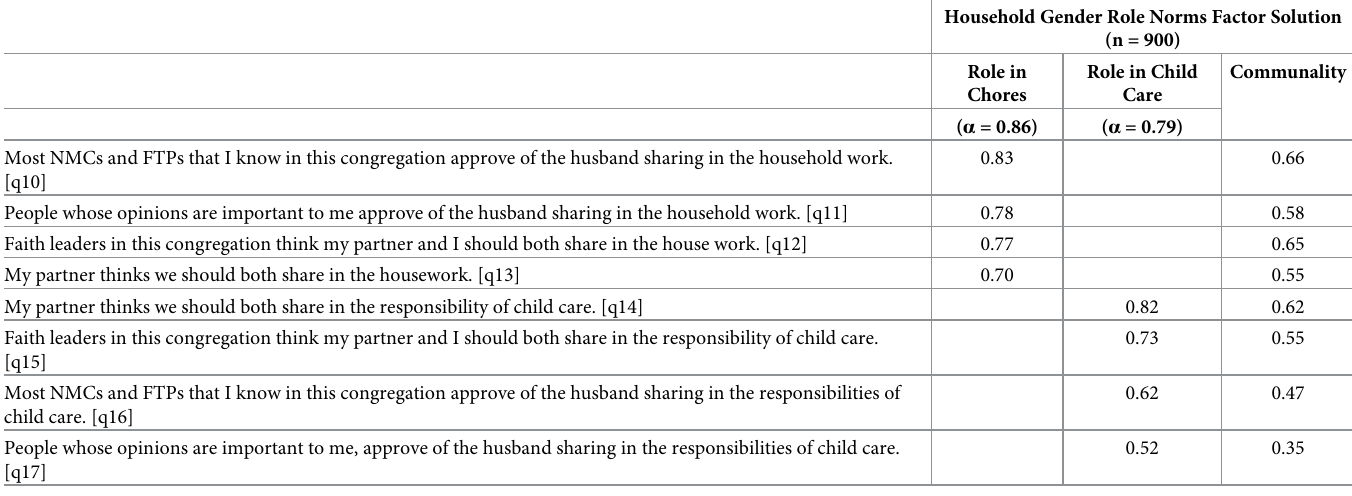
Table 5. Factor loadings and communalities based on exploratory factor analysis for items related to social norms for gender equity among men and